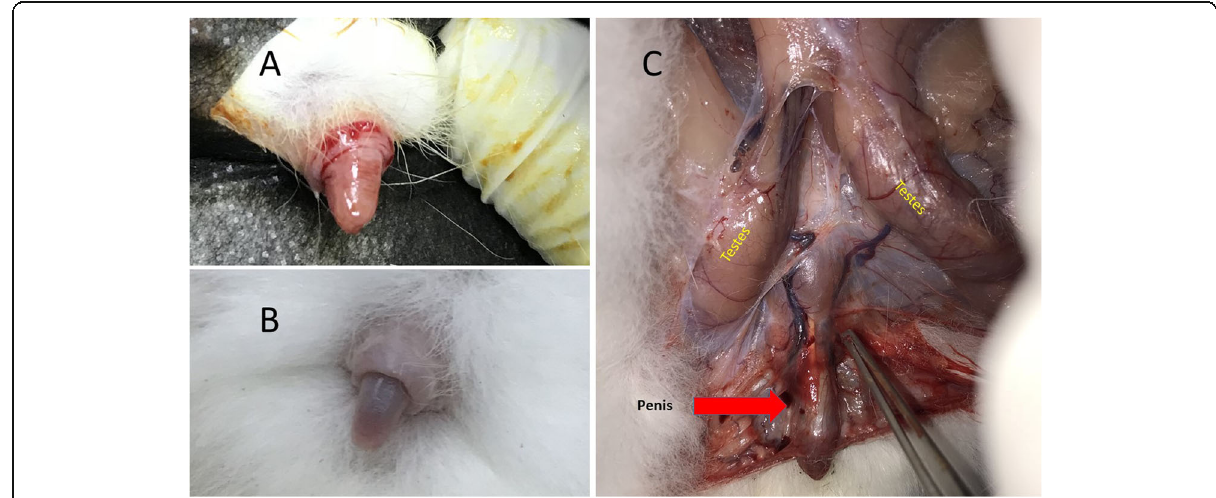
Fig. 2 Views of the penis after circumcision ( a early postoperative, b late postoperative) and during dissection ( c )